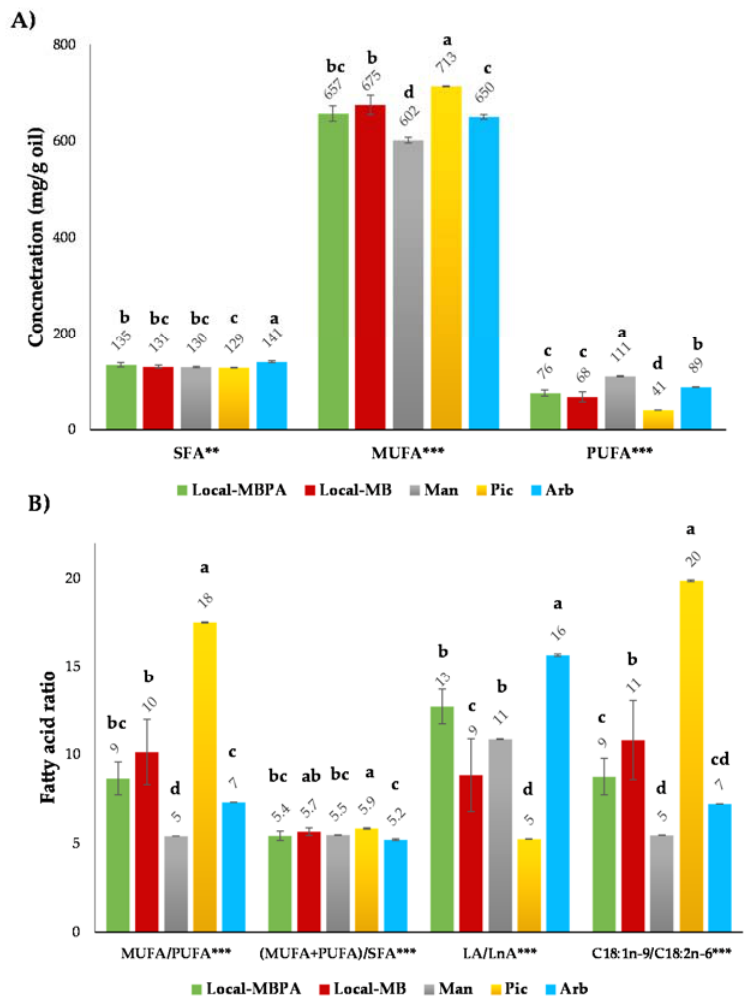
Figure 1. Fatty acid composition ( A ) and fatty acid ratio ( B ) of the virgin olive oils (VOOs). ** ( P ≤ 0.01); *** ( P ≤ 0.001). a–d Mean values in the same row with different letters indicate